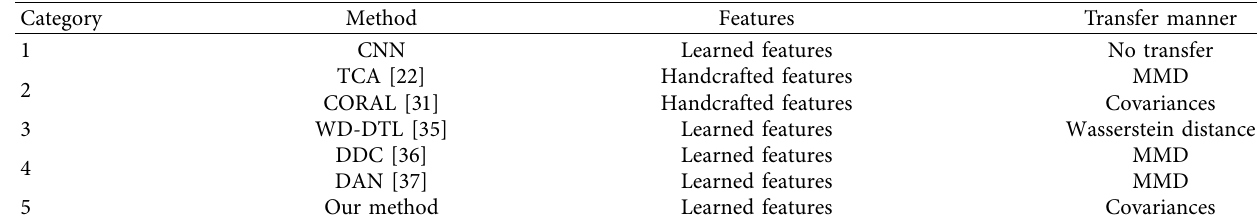
Table 4: Parameters and category of compared